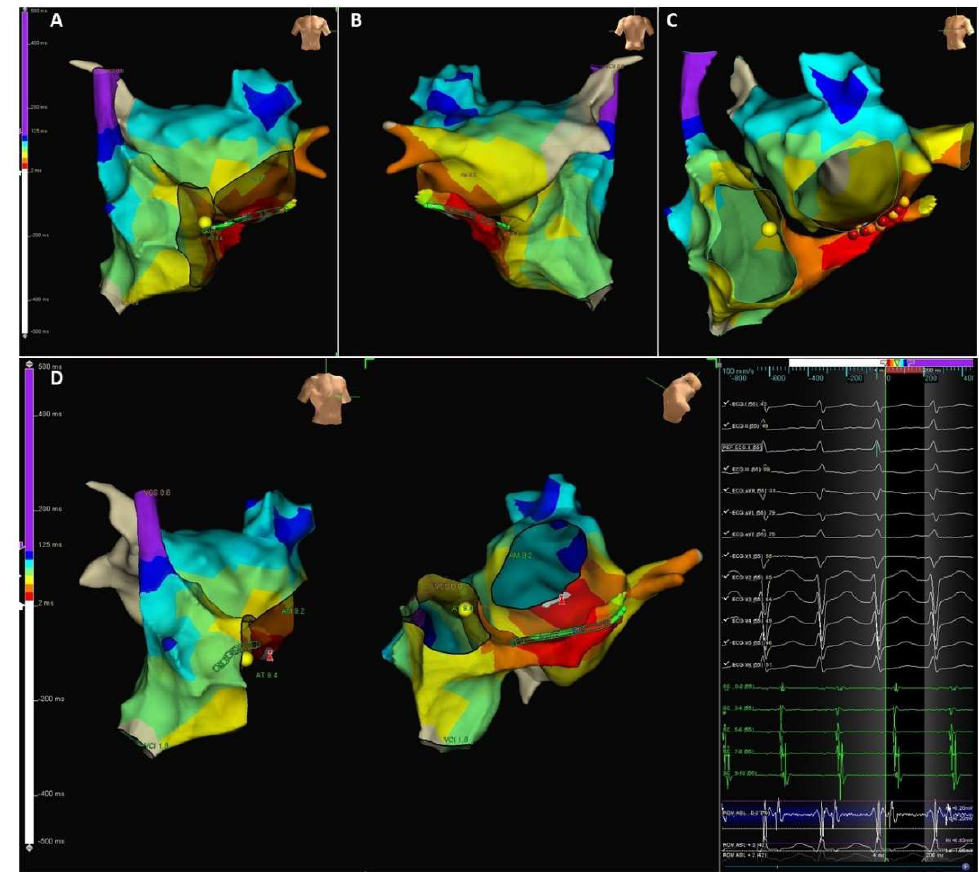
Figure 10. Supraventricular tachycardia due to left accessory pathway activation map. Electroanatomic map of activation times of the right and the LA, performed during supraventricular tachycardia due to concealed accessory left pathway. The atrial anatomy was determined by the impedance catheter localization system integrated into the NAVEx system. Activation sequence was derived from semi-automated sequential analysis of local electrograms. Activation times are color-coded with red indicating sites with earliest activation and purple sites with latest activations. ( A – C ): 3 images of the same map are shown in anteroposterior (AP) posterior anterior (PA) and caudal left anterior oblique (LAO) projections, respectively. ( D ): 2 images of the same map are shown in right anterior oblique (RAO) and caudal projections, respectively. The earliest site is the posterolateral part of mitral